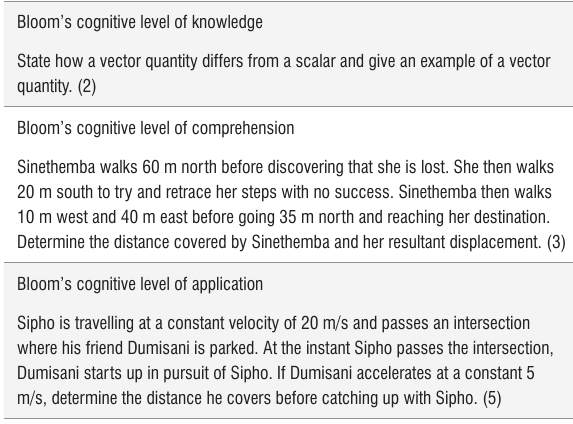
Sample test questions for the first three levels of Bloom’s cog- nitive levels